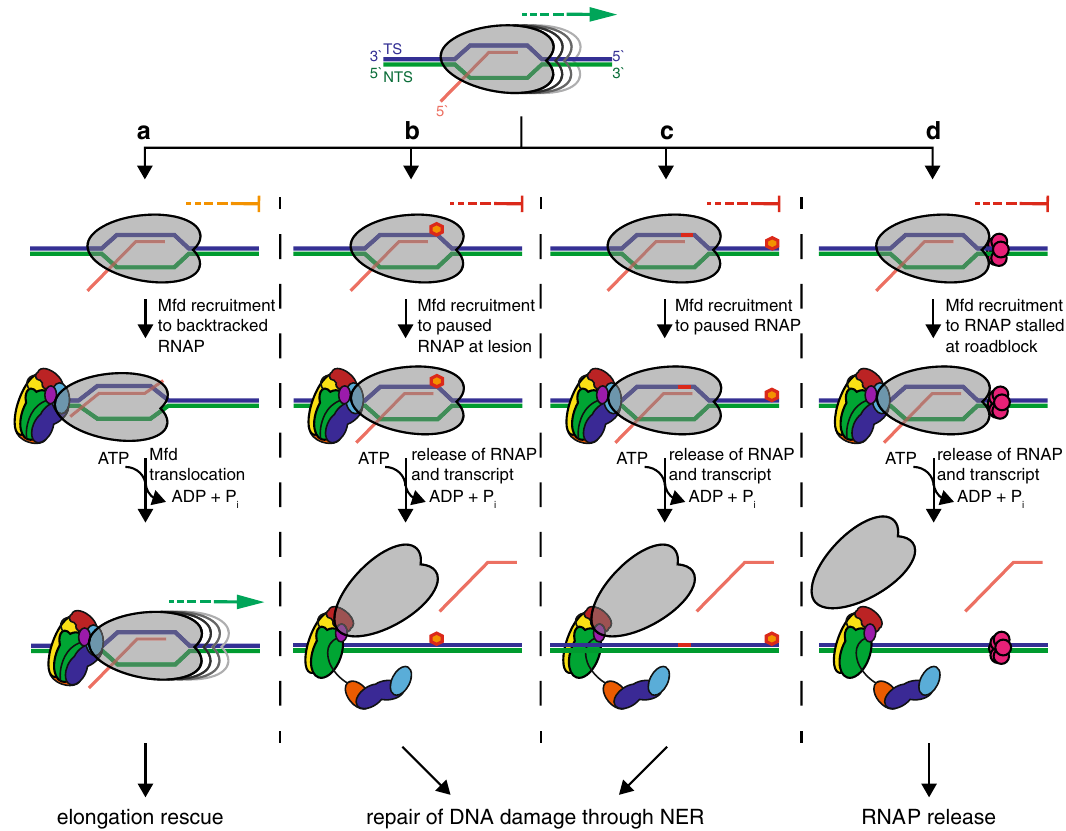
Fig. 1 All Mfd functions are dependent on translocation on DNA or action upstream of transcription elongation complexes. Shown at the top is a schematic of an elongating RNAP (gray) with labeled nucleic-acid moieties (RNA, red; NTS, non-template strand, green; TS, template strand, blue) that can either become stalled or temporarily paused as indicated in a – d . a In Mfd-dependent rescue of class II transcriptional pausing, Mfd binds to backtracked RNAPs and promotes their forward translocation thereby rescuing transcript elongation 16,26 . b In canonical TCR, RNAP becomes stalled at a lesion (orange hexagon) on the TS and recruits Mfd (colored by domain, with D1a and D1b in blue, D2 in cyan, D3 in orange, D4 (RID) in magenta, D5 in yellow, D6 in green and D7 in red), either through 3D-diffusion or 1D-diffusion, enabled by a catch-up-then release mechanism dependent on ATP hydrolysis 16 , disruption of the D2 – D7 clamp, RNA release, and UvrAB recruitment 29,31 . c In repair “ at a distance ” , Mfd is recruited to RNAP paused at class II pause signals (red line), which is fi rst released off the nucleic-acid chains and acts as a processivity factor for Mfd to translocate toward downstream lesions in the TS, and initiate strand-speci fi c repair 17 . d When RNAPs collides with protein roadblocks head-on, including replisomes, Mfd will release RNAP off the nucleic-acid chains, thereby freeing the DNA for other DNA-based processes 18,19